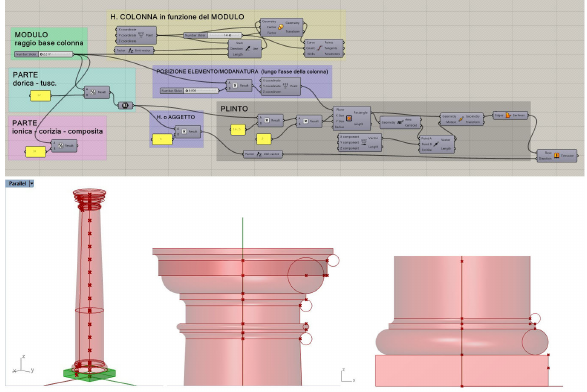
Figure 5. Parametric modeling for Architectural Orders